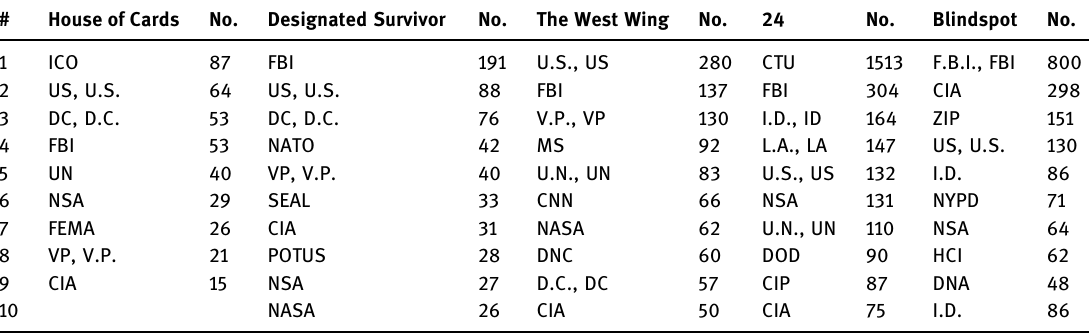
Table 1: Top occurrences in the series # House of